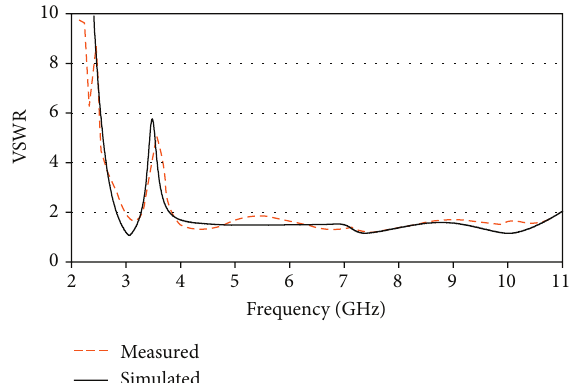
Figure 7: VSWR curves of the proposed antenna.